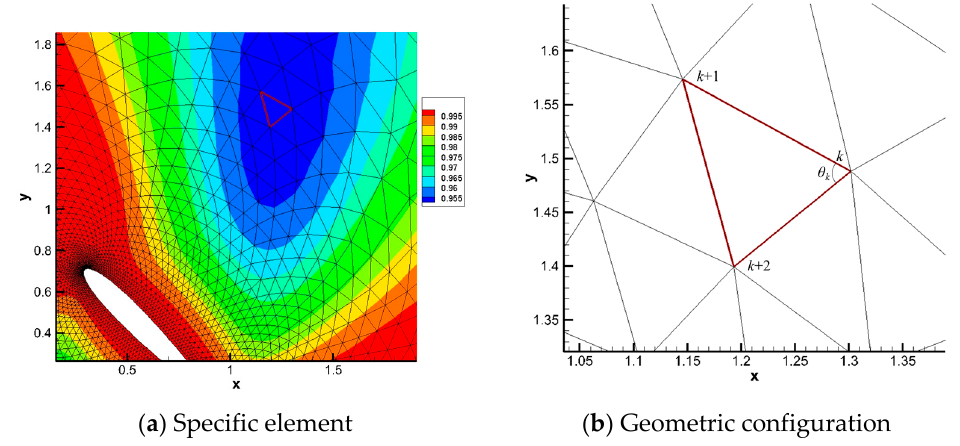
Figure 11. Specific element with minimal skewness metrics.